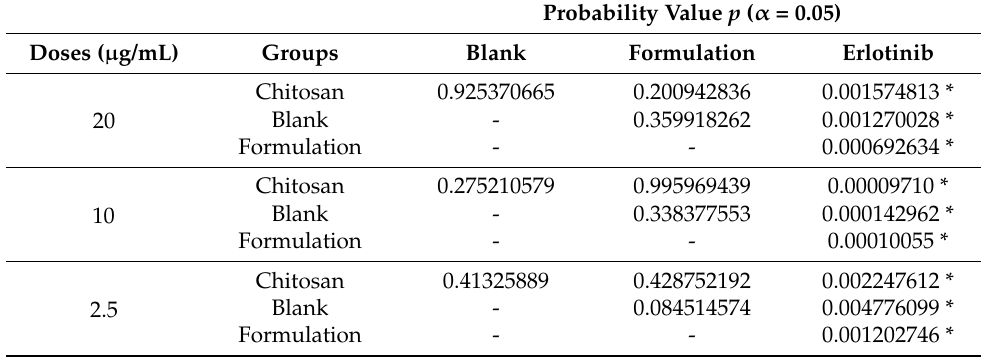
Table 11. Tukey Test: multiple comparisons.